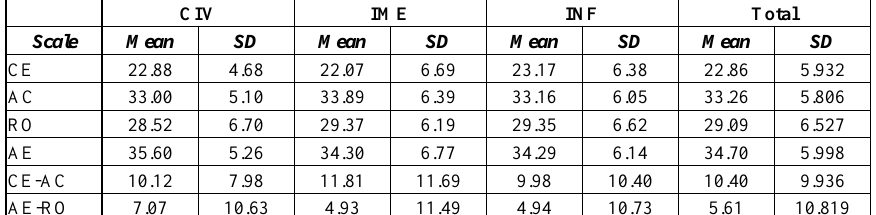
Table 7. Mean scores and standard deviations (SD). CIV- Civil Engineering; IME